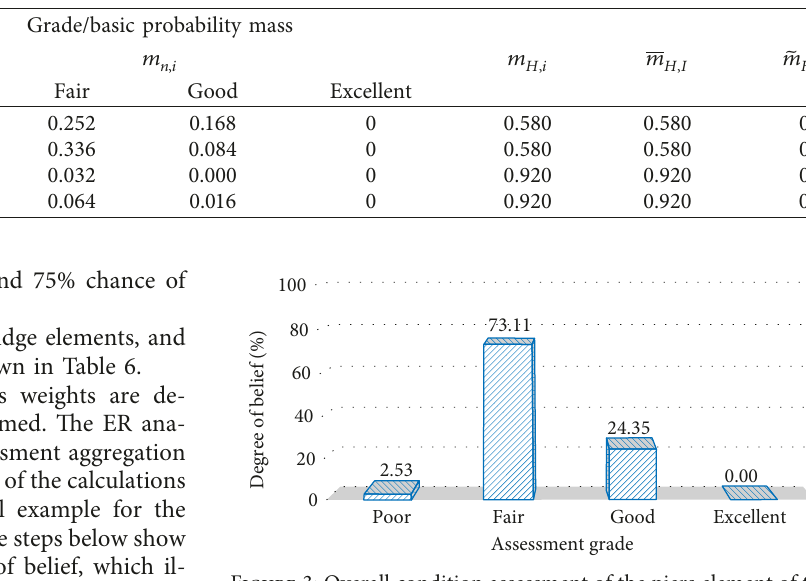
Table 7: Basic probability masses of the piers elements considering the various assessment grades.